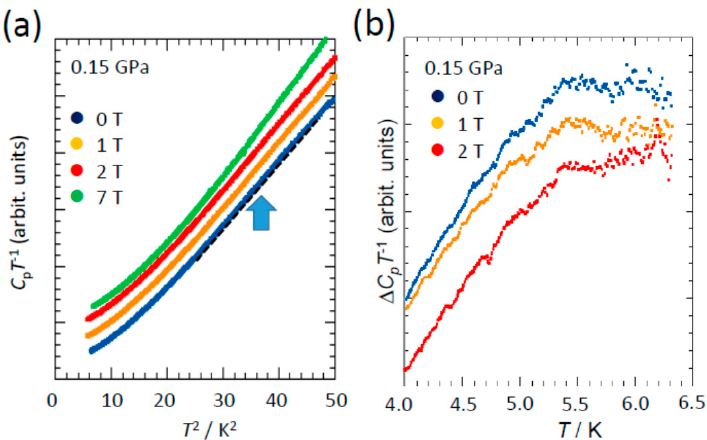
Figure 6. ( a ) C p T − 1 vs. T 2 plot of the ac heat capacity of κ -(BEDT-TTF) 2 Cu(NCS) 2 at 0.15 GPa with magnetic fields of 0 T, 1 T, 2 T, and 7 T. The values of C p T − 1 under magnetic fields are plotted with constant offsets in the vertical axis. The arrow indicates the superconductive transition temperature at 0 T; ( b ) temperature dependence of the ∆ C p T − 1 at 0.15 GPa obtained by subtracting the 7-T data as the background (details are reported in Ref. [32]).